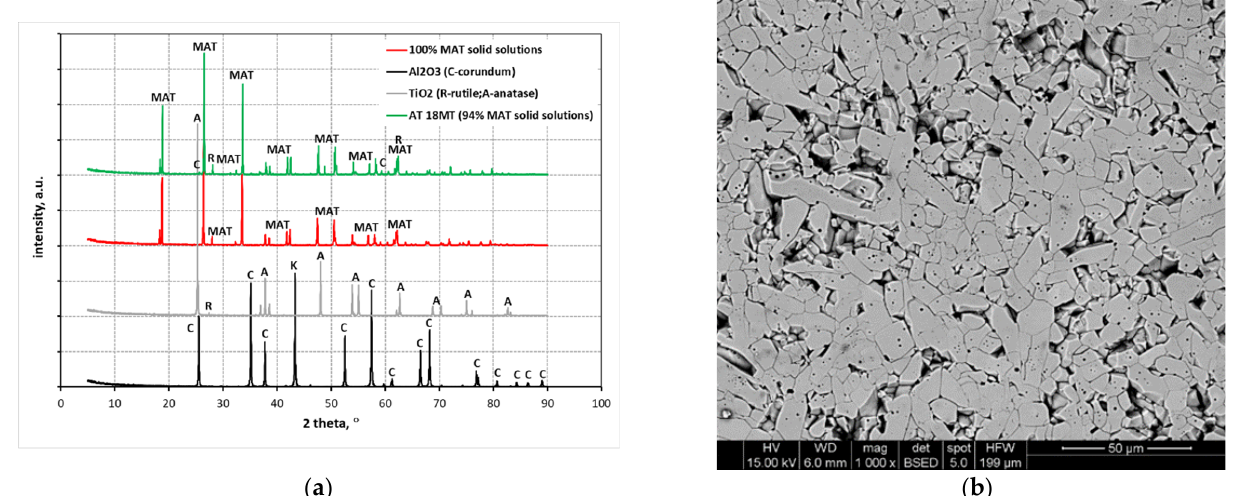
Figure 7. XRD analysis results for a pure MAT solid solution obtained in a non-stoichiometric system ( a ) and SEM image showing the microstructure of a pure MAT solid solution with visible grain chipping formed during polishing ( b ).